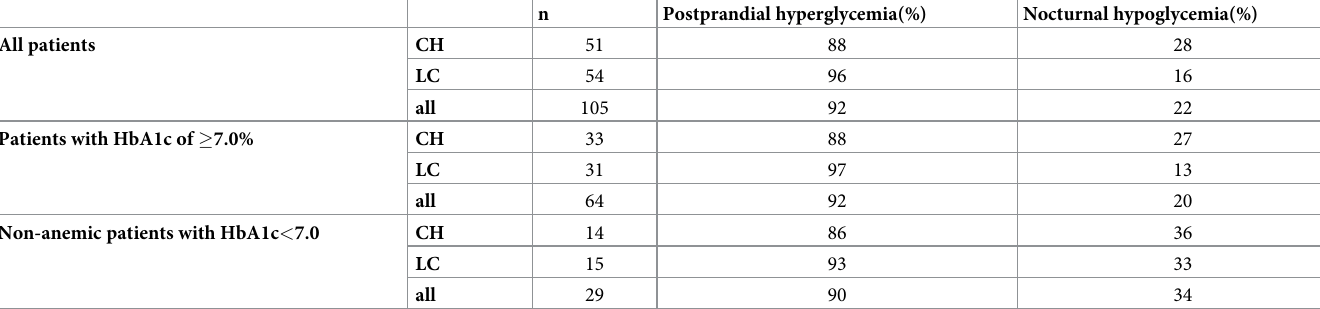
For abbreviations, see Table